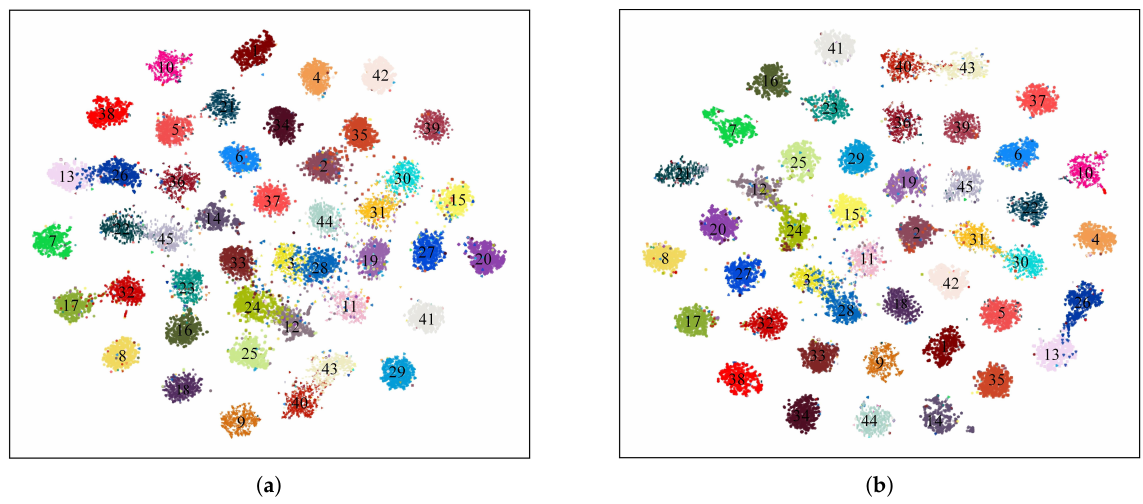
Figure 13. Two-dimensional scatterplots of high-dimensional features on the NWPU-RESISC45 dataset (training ratio = 20%). ( a ) ResNet50 backbone. ( b ) The proposed